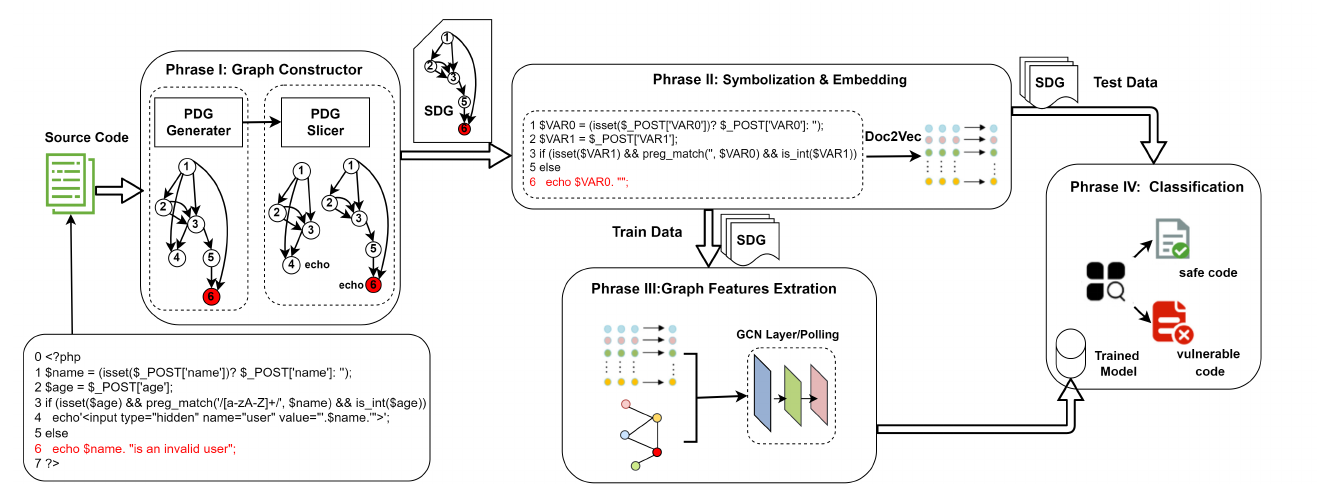
Figure 1. VulEye